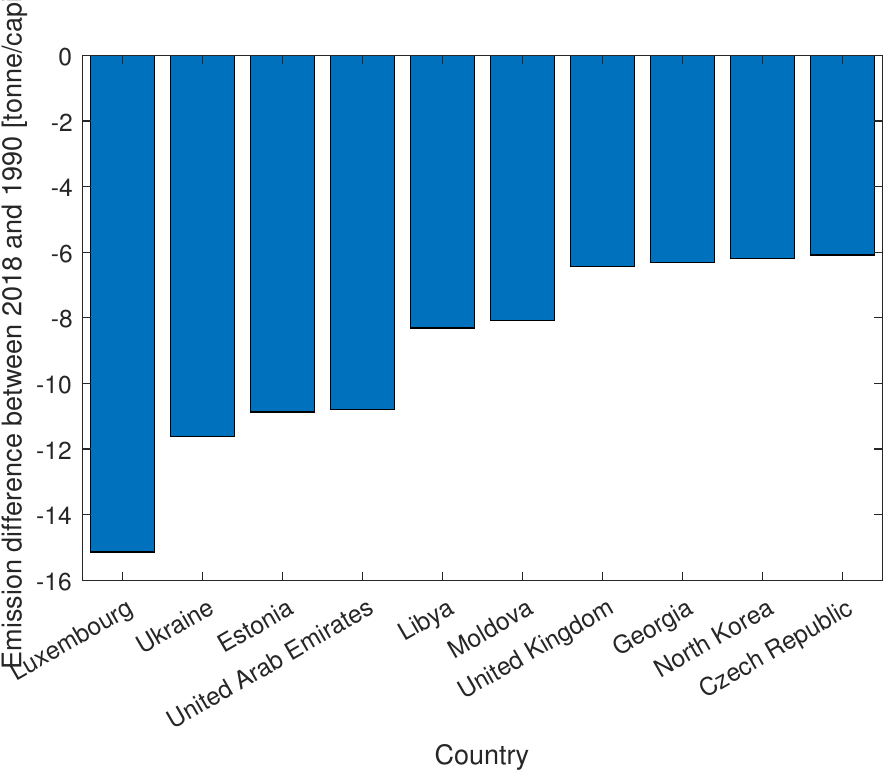
Figure 9. The difference between the GHG emissions measured in 2018 and 1990. The top ten countries that have decreased their GHG emissions the most. The absolute scale can focus on the global contribution of countries to GHG